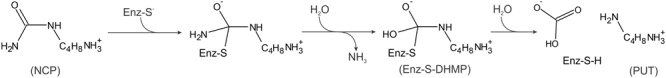
A scheme of enzymatic hydrolysis of NCP to PUT. Enz-S-DHMP indicates the covalent complex with N-(dihydroxymethyl)putrescine, observed in the MtCPA/DHMP structure.